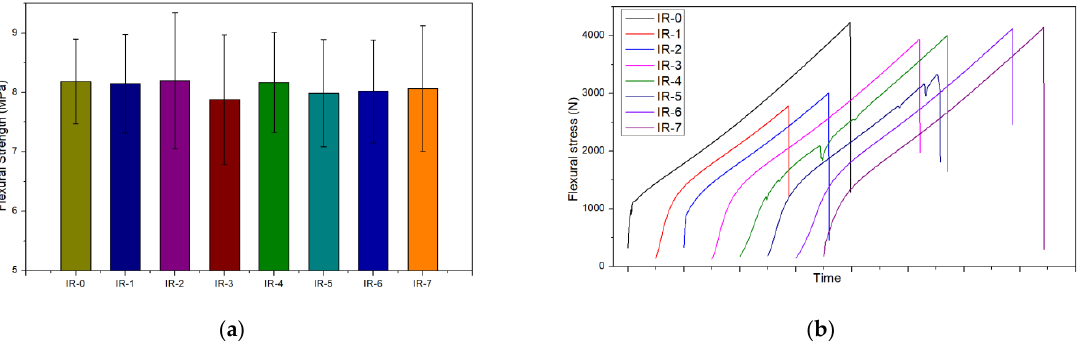
Figure 10. Data of the three-point bending tests on the IR- series samples. ( a ) Flexural strengths and ( b ) flexural stresses of typical testing samples, with time axis offsets.